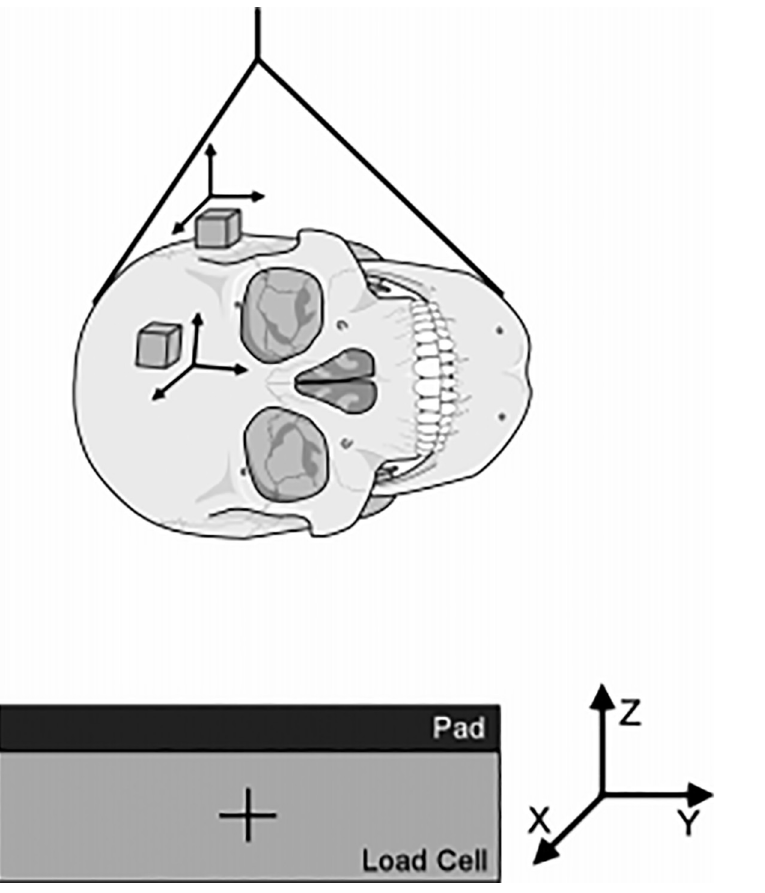
Fig 9. Diagram of Yoganandan cadaver experiment device.